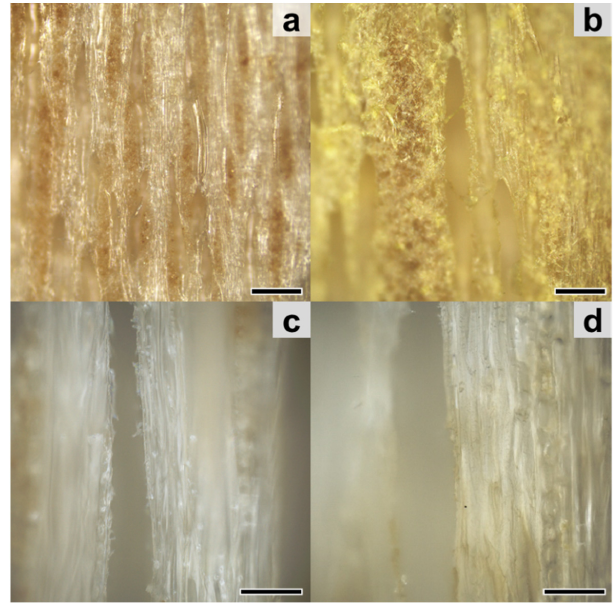
Figure 4. Confocal laser scanning microscope (CLSM) micrographs of untreated ( a , c ), HWE-treated ( b ) and KWE-treated ( d ) tangential sections of beech sapwood ( Fagus sylvatica ). Magnifications of 10×, 20× and 50×.